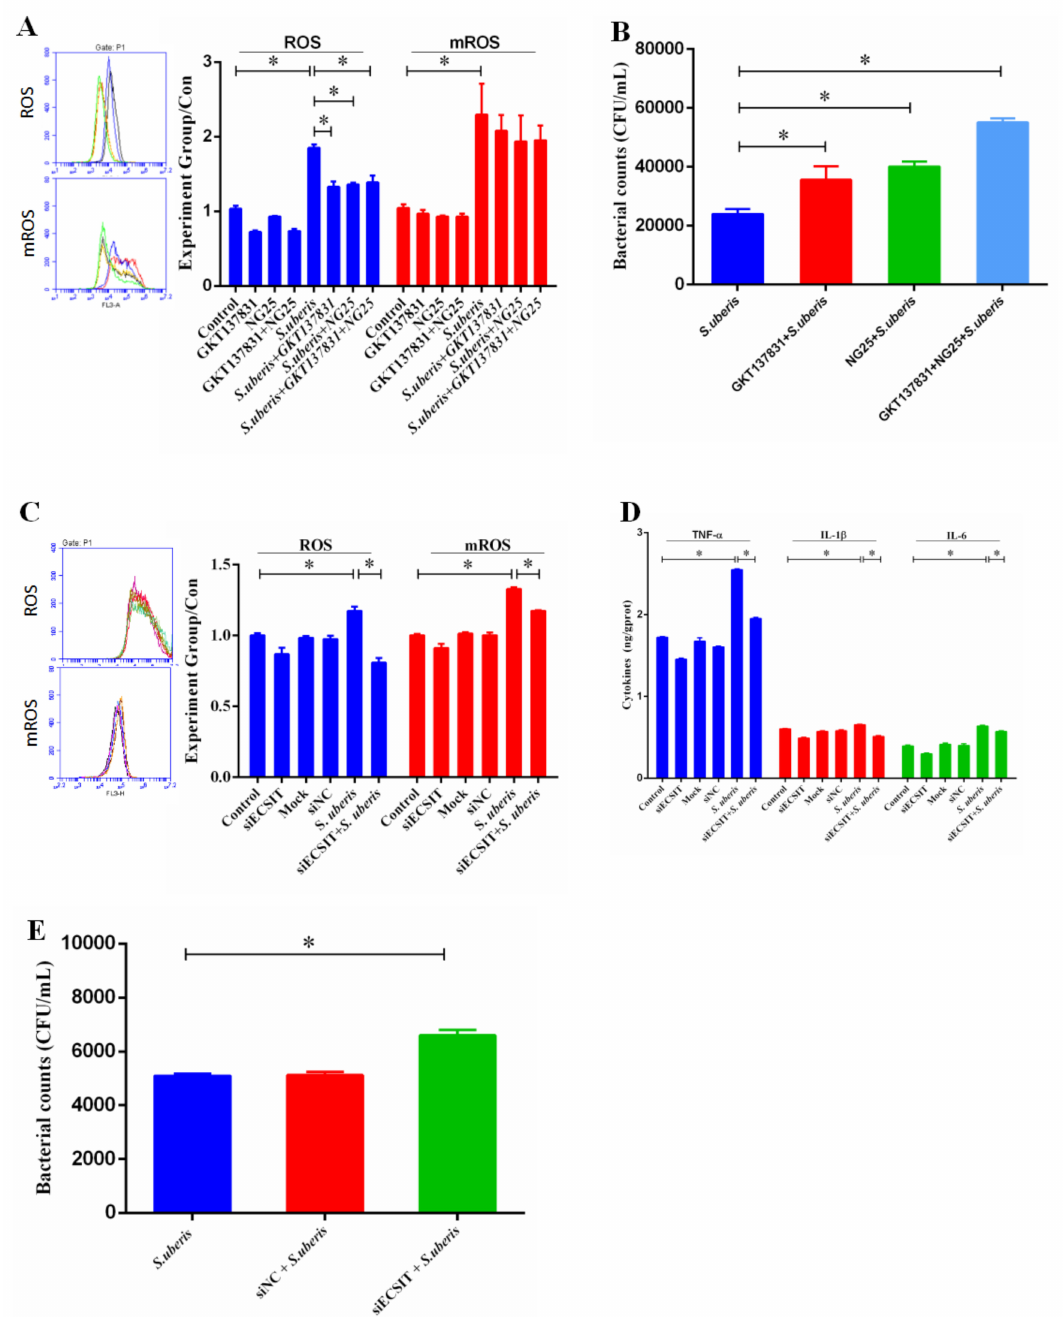
Figure 6. mROS plays an important role in anti- S. uberis infection in MECs. ( A ) The levels of ROS and mROS after using GKT137831 and NG25 simultaneously or separately with or without S. uberis infection in MECs. ( B ) Viable bacteria were counted via the plate with THB agar medium after using GKT137831 and NG25 simultaneously or separately during S. uberis infection in MECs. ( C ) The levels of ROS and mROS after using siECSIT in MECs of Control and siECSIT groups with or without S. uberis infection. ( D ) The expressions of TNF- α , IL-1 β and IL-6 after using siECSIT in MECs of control and siECSIT groups with or without S. uberis infection. ( E ) Bacteria counts after using siECSIT in MECs of Control and siECSIT groups during S. uberis infection. All experiments were repeated three times and all data were presented as the means ± SEM ( n = 3). * ( p < 0.05) = significantly di ff erent between the indicated